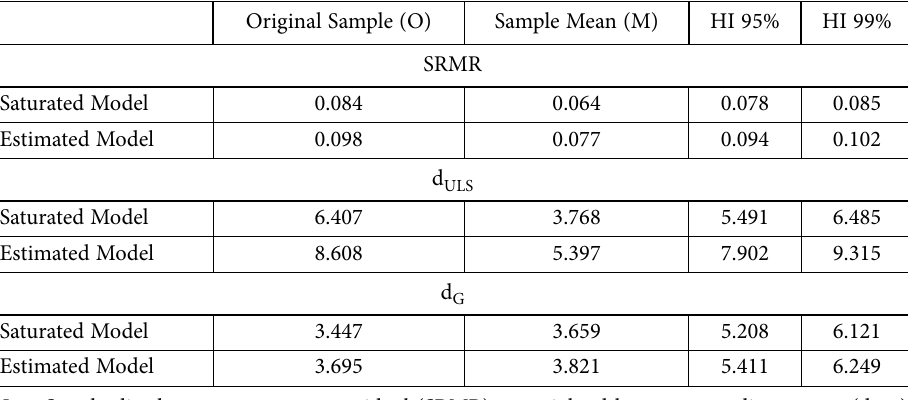
Table 2. Global model fit